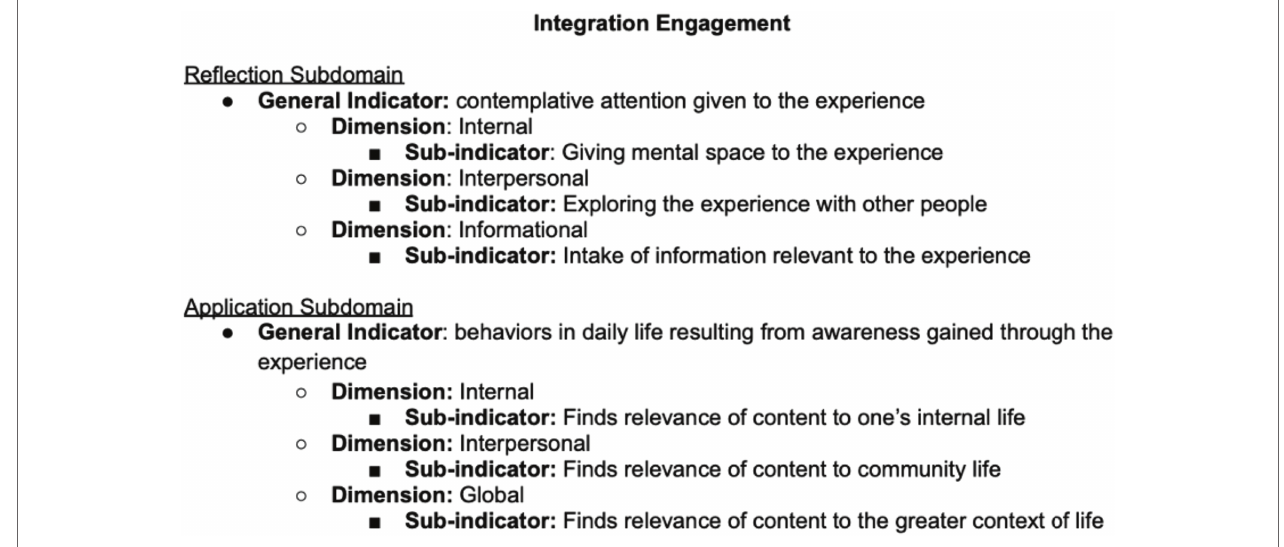
FIGURE 3 | Subdomains, indicators, and sub-indicators for the integration engagement scale